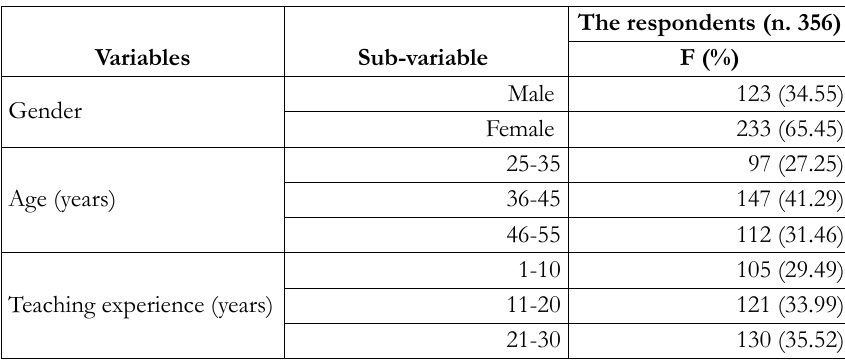
Table 2. Survey respondent